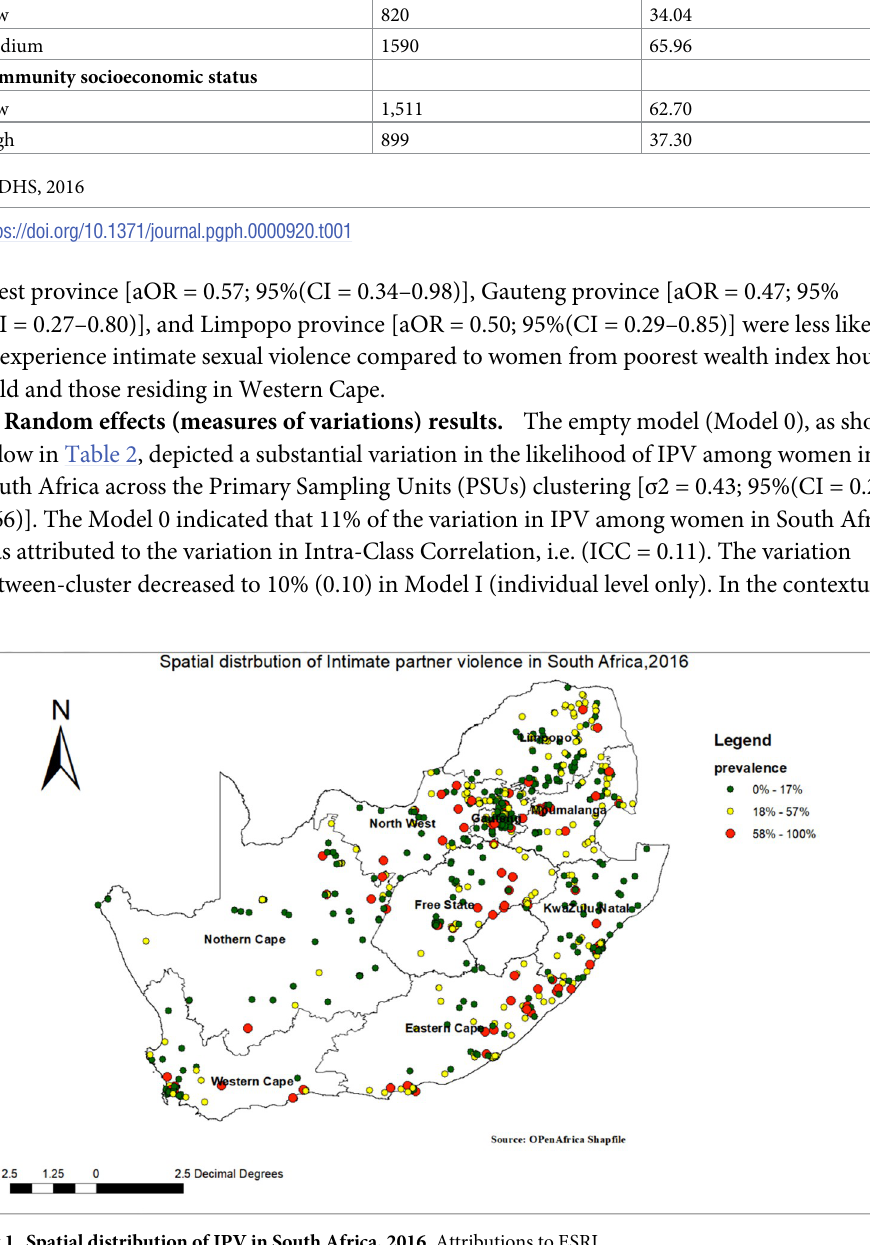
Fig 1. Spatial distribution of IPV in South Africa, 2016. Attributions to